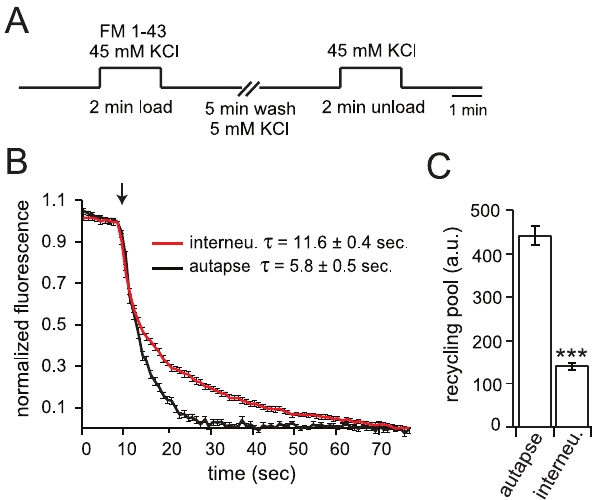
Figure 6. Analysis of synaptic vesicle recycling pool size and kinetics of exocytosis using FM dye. (A) Schematic of the FM1-43 dye loading and unloading protocol used to determine recycling vesicle pool size and destaining kinetics. Synaptic vesicles were loaded with FM1-43 for 2 min using 45 mM KCl, washed for 5 min and then unloaded with 45 mM KCl during image acquisition at 1 second intervals. (B), Quantitation of FM1-43 destaining in autaptic synapses and interneuronal synapses. A baseline of 10 images was collected prior to destaining by addition of 45 mM KCl, indicated by the arrow. (C) Recycling vesicle pool size calculated from the total FM1-43 fluores- cence loss from boutons following stimulation for autaptic and interneuronal synapses. (n=41; 5 different coverslips for autaptic synapses and n=55; 6 different coverslips for interneuronal synapses). Statistical significance was determined by a Student’s t-test. ***p , 0.001. All data shown represent mean 6 SEM.